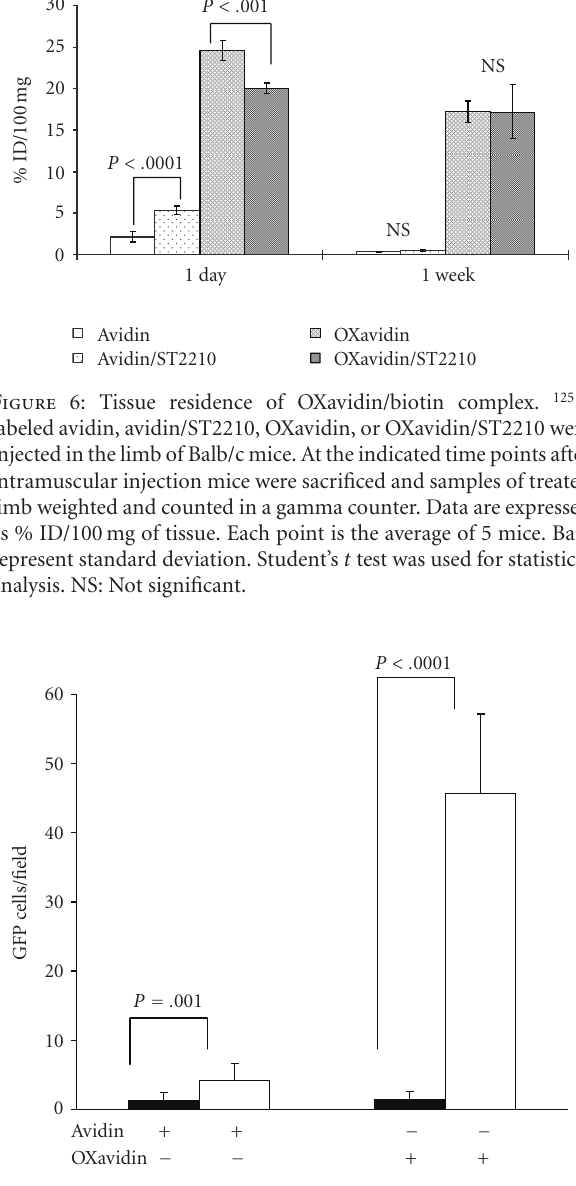
Figure 7: OXavidin uptake of biotinylated cells. OXavidin shows highly e ffi cient uptake of biotinylated GFP-expressing B16 cells compared to avidin. Black and white histograms indicate the average of nine fields of B16 and biotinylated B16 cells, respectively. Bars represent standard deviation. Student’s t test was used for statistical